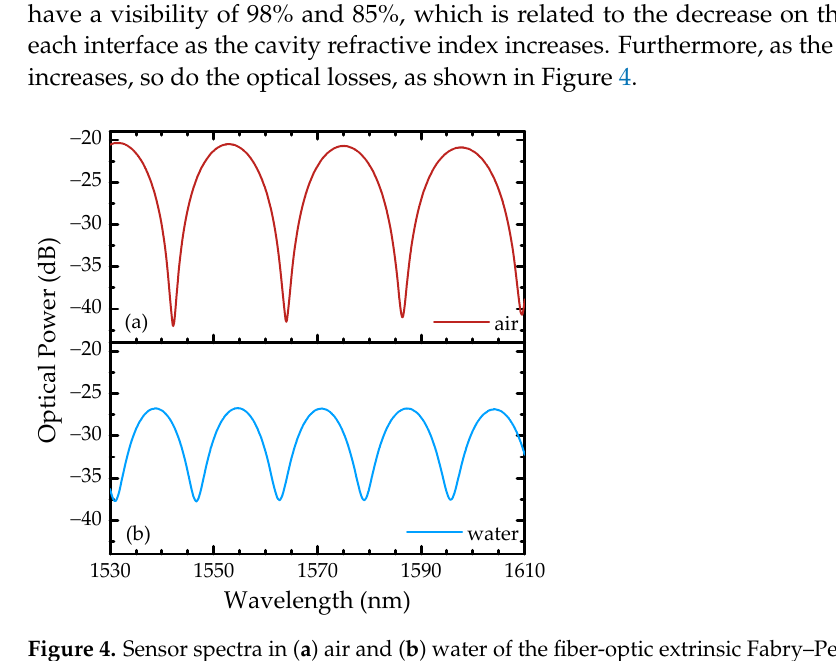
Figure 4. Sensor spectra in ( a ) air and ( b ) water of the fiber-optic extrinsic Fabry–Perot interferometer recorded from 1530 to 1610 nm in the optical spectrum analyzer.